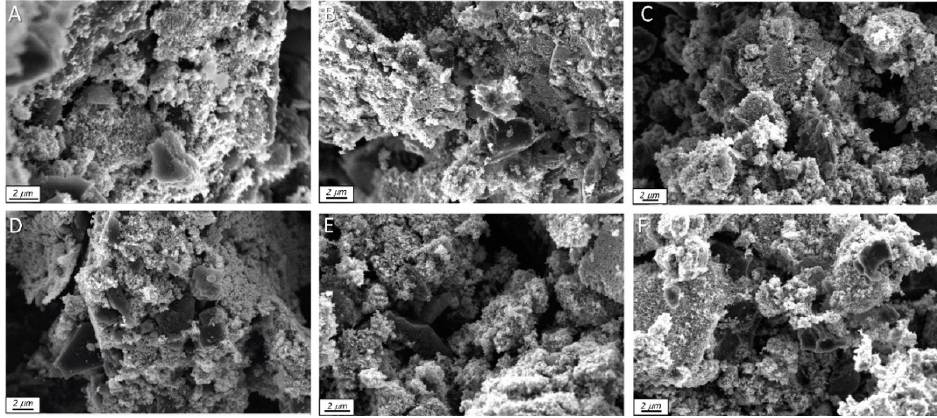
Figure 7. SEM images. ( A ) T/BAX; ( B ) T/C1; ( C ) T/C2; ( D ) T/BAX-S; ( E ) T/C1-S; ( F ) T/C2-S. Molecules 2019 , 24 , x